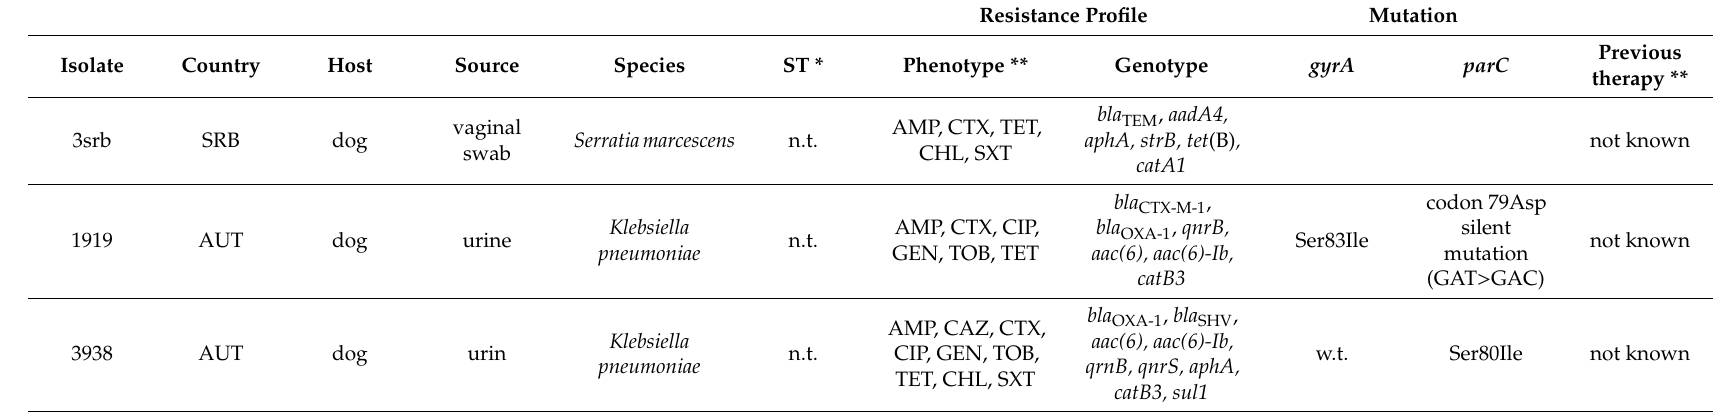
Table 2. Molecular characterization and resistance to antibiotics of canine and feline non- E. coli Enterobacterales isolated from urogenital infections and originating from Austria (AUT) and Serbia